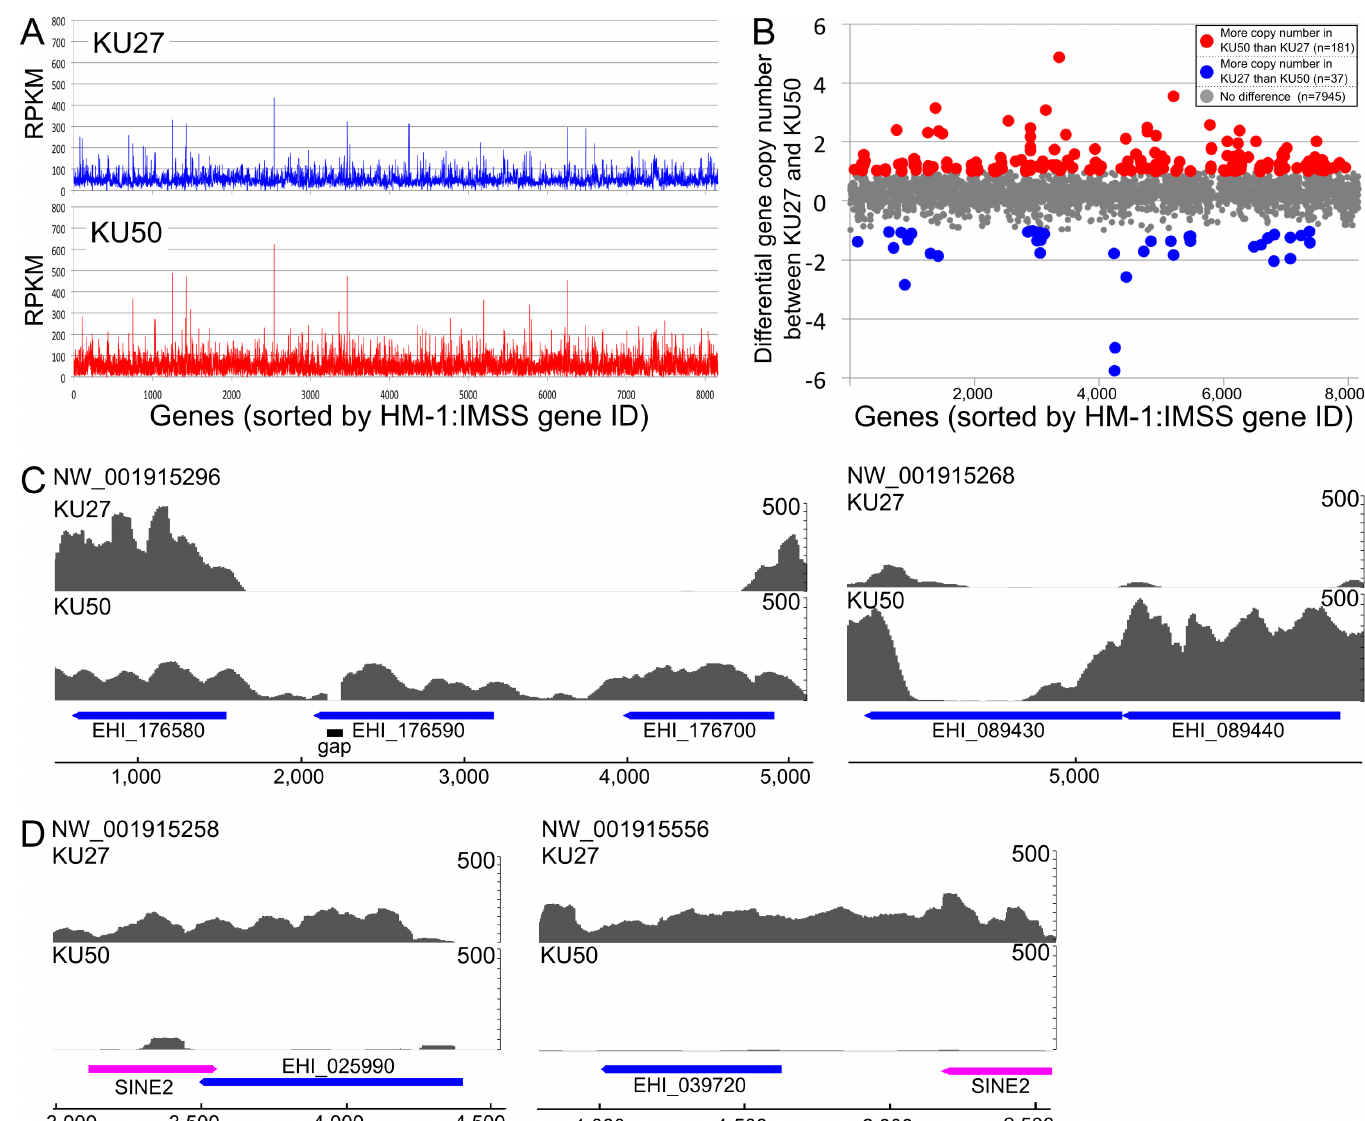
Fig 1. Comparative genome analysis of E . histolytica strains KU27 and KU50. ( A) RPKM score of the genomes of strains KU27 and KU50. The X-axis represents 8,163 annotated genes of E . histolytica HM-1:IMSS in the order of locus tag gene ID. (B) Gene copy number variations in KU27 and KU50. RPKM scores of 3252 genes, with a higher value than the RPKM median of all genes, are shown. The 181 genes that are present at higher copy number in KU50, compared to that in KU27, are displayed as red dots; the 37 genes, present in higher copy number in KU27 compared to that in KU50, are shown as blue dots. The x-axis represents 8,163 annotated E . histolytica HM-1:IMSS genes ordered by locus tag gene ID. The y-axis represents the number of gene copies, per gene, expressed as KU50 gene copy number minus KU27 gene copy number. (C, D) Raw mapping data of KU27 and KU50 reads to the regions that contain genes present in KU50, but absent in KU27 (C), and those present in KU27, but absent in KU50 (D). E . histolytica HM-1:IMSS reference genome sequence was used for mapping. The y-axis displays mapping read coverage.